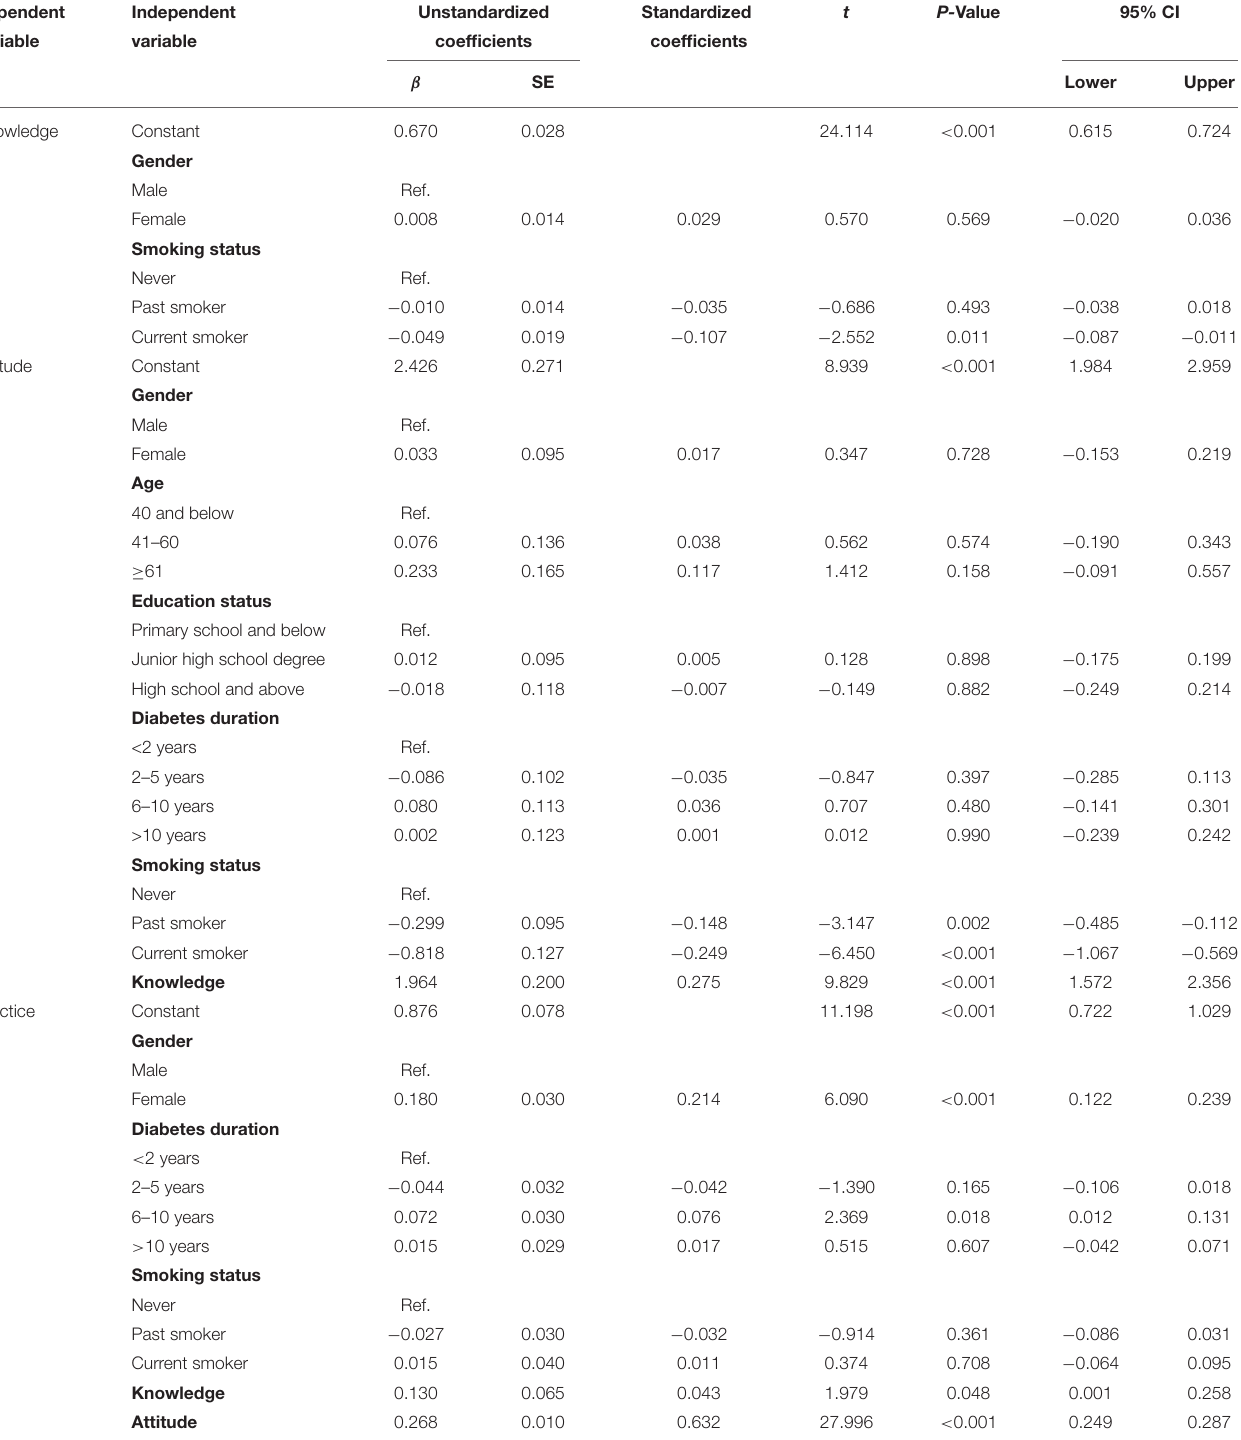
TABLE 6 | Multiple linear regression results of knowledge, attitudes, and practices toward diabetic foot prevention. Dependent Independent